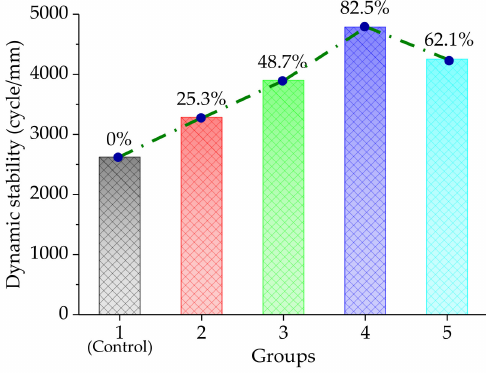
Figure 8. High-temperature rutting test results.